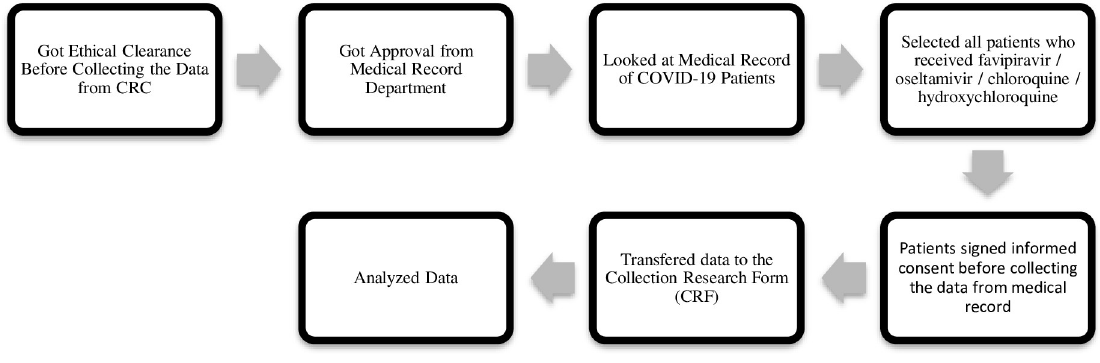
Fig 1. Research framework of the